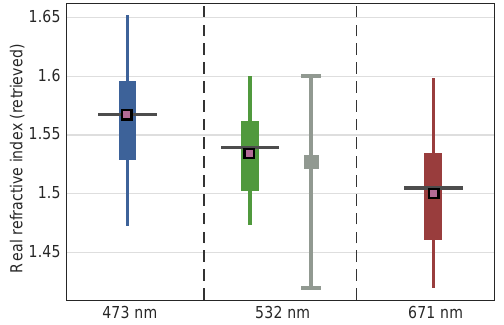
Figure 10. Retrieved refractive index at all three PI-Neph wave- lengths for the 50 selected SEAC 4 RS samples. Box and whisker plots show the data distribution by quartile while the connected black squares show the spectral dependence of the mean. The gray bounds at 532nm denote the minimum and maximum values mea- sured by Shingler et al. (2016) in SEAC 4 RS while the gray square denotes the corresponding